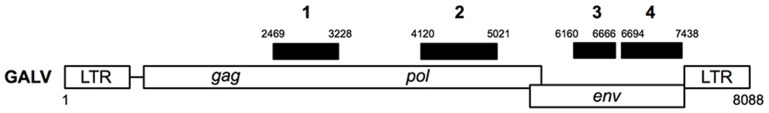
Relative positions of MbRV fragments with respect to GALV genome.Schematic showing the relative positions of the four MbRV fragments (dark bars) and the positions in which they align against the GALV genome. MbRV sequenced fragments are labeled 1–4 starting from the 5′ end the genome.